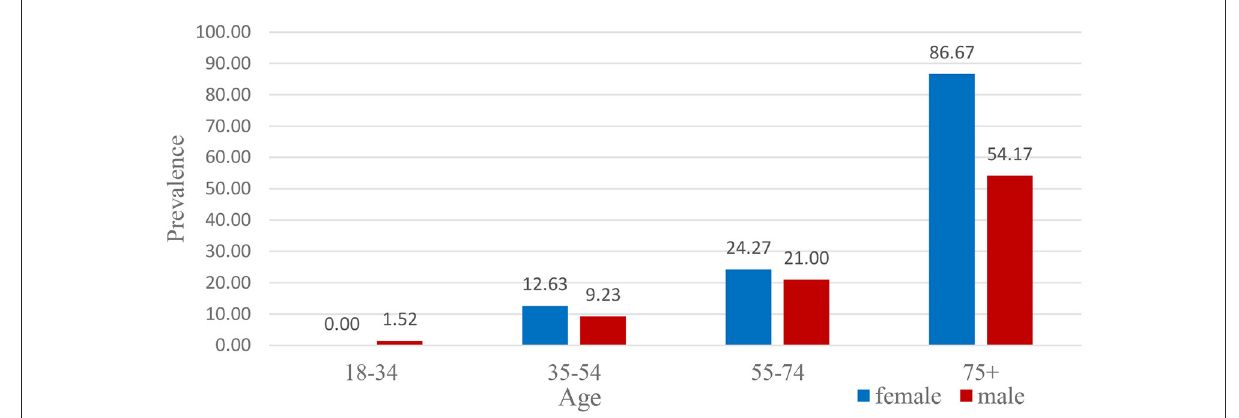
FIGURE1 Percentage of foot ulcers in diabetic subjects according to age.